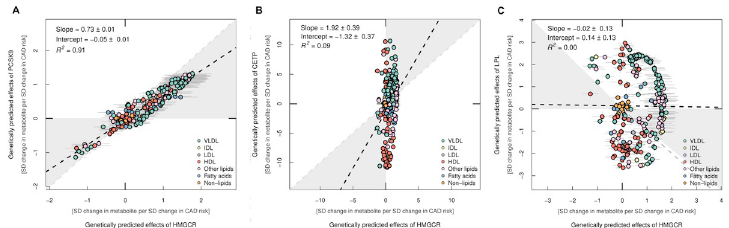
Fig 4. A comparison of distributions between genetically predicted drug target effects (A) PCSK9, (B) CETP, and (C) LPL on metabolic traits using NMR in the UKB study. In each figure estimates are compared with the results from the HMGCR score. Effect estimates were scaled in accordance with the corresponding effects of these genetically predicted drugs targets on risk of CAD, which is why axes vary between plots. Points are coloured based on subcategories of metabolic traits indicated in the figure legends. The data underlying this figure can be found in S7, S8, S10, and S14 Tables. CAD, coronary artery disease; CETP, cholesteryl ester transfer protein; HDL, high-density lipoprotein; IDL, intermediate density lipoprotein; LDL, low-density lipoprotein; NMR, nuclear magnetic resonance; SD, standard deviation; UKB, UK Biobank; VLDL, very low-density